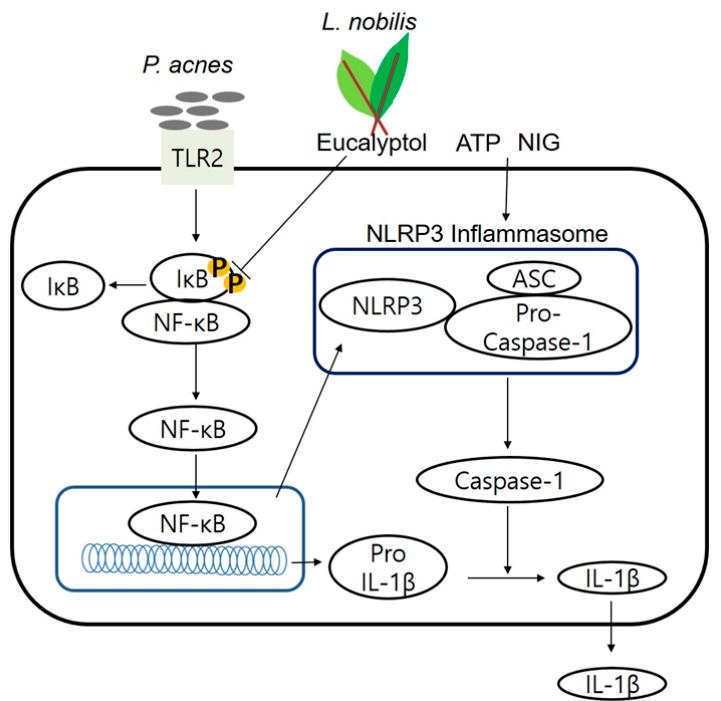
Figure 8. A model of L. nobilis leaf extract in the suppression of P. acnes -induced skin inflammation. L. nobilis exerts anti-inflammatory effects in acne lesions by inhibiting NF- κ B signaling pathways.